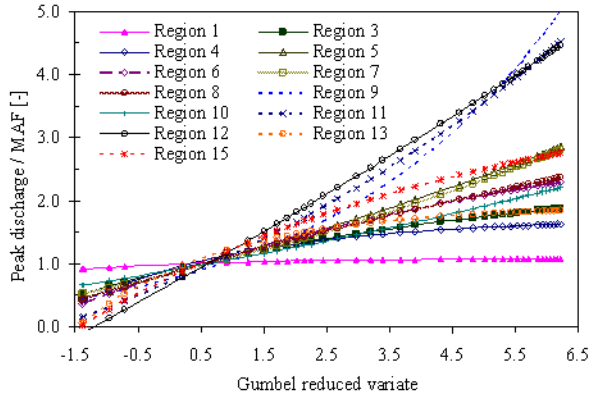
Fig. 7. Regional growth curves developed using GEV distribution for the homogeneous regions in the River Nile